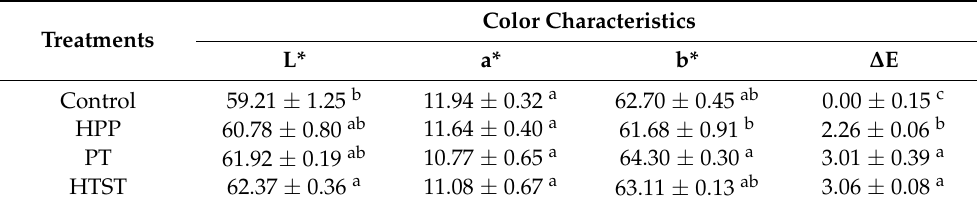
Table 3. Effect of high-pressure processing (HPP), pasteurization (PT), and high-temperature short time (HTST) on color characteristics (L*, a*, b* and ∆ E values) of passion fruit pur é